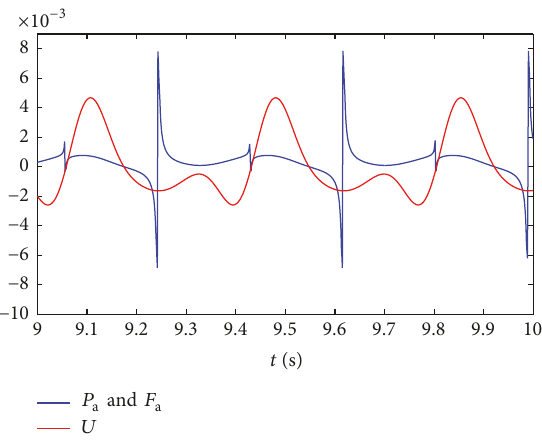
Figure 12: PD control signal for constant velocity ( 𝑥 2∗ = 16.83 rad/s = 20 km/h) with double-cylinder excited by pressure (normalized).